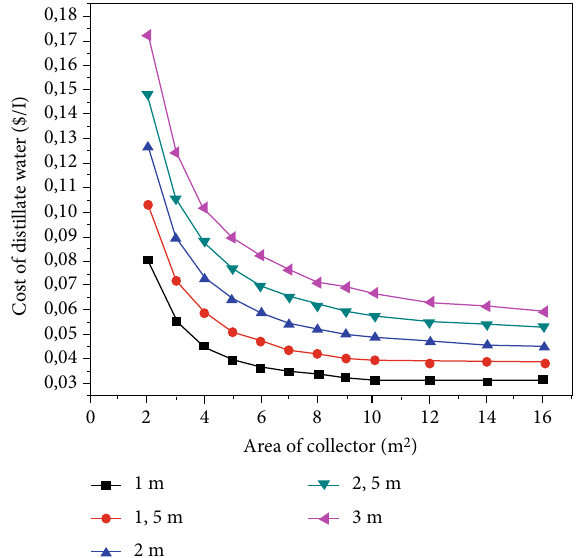
Figure 20: E ff ect of the collector area on the cost of distilled water